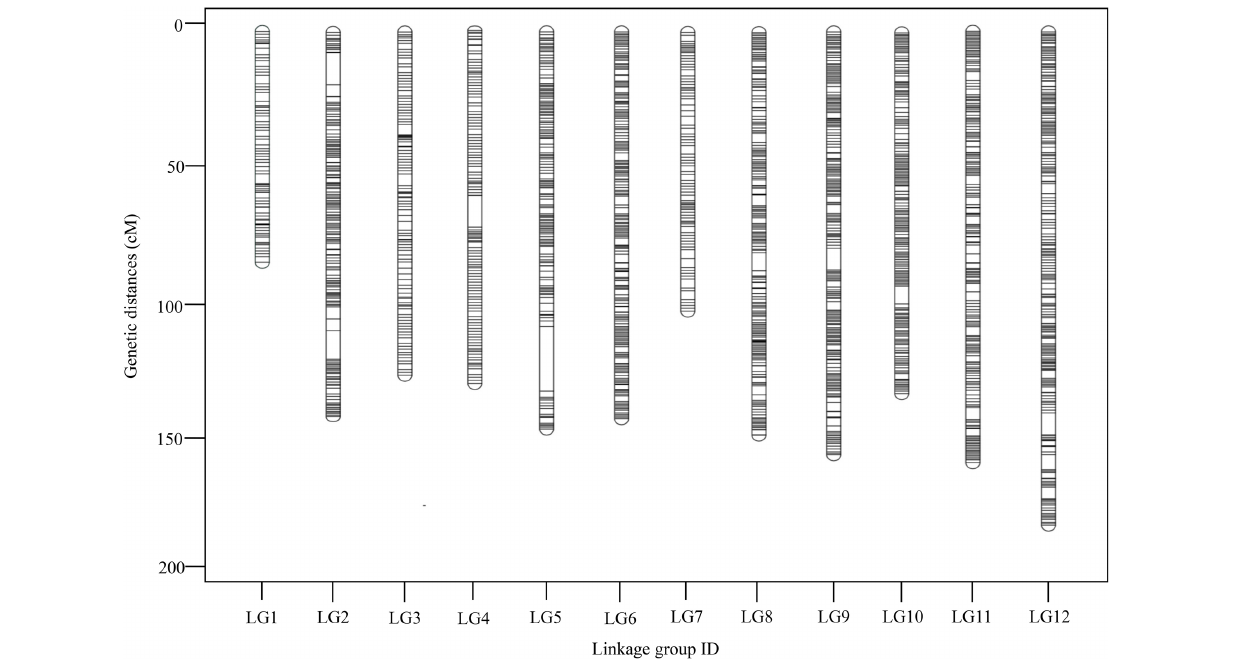
Frontiers in Plant Science |